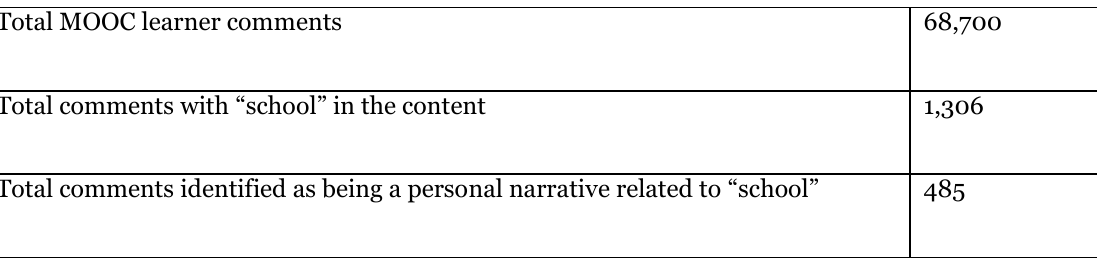
Process of Sampling Personal Narratives from MOOC Learner